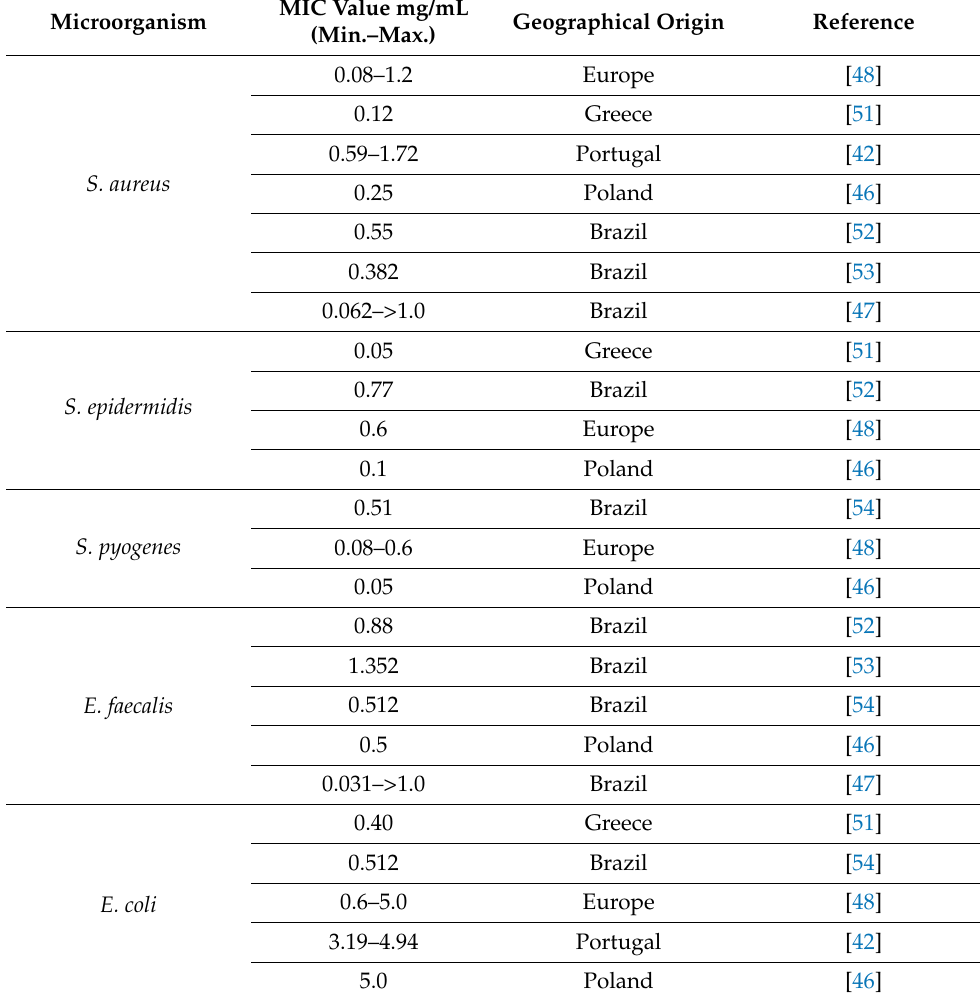
Table 2. Activity of propolis against